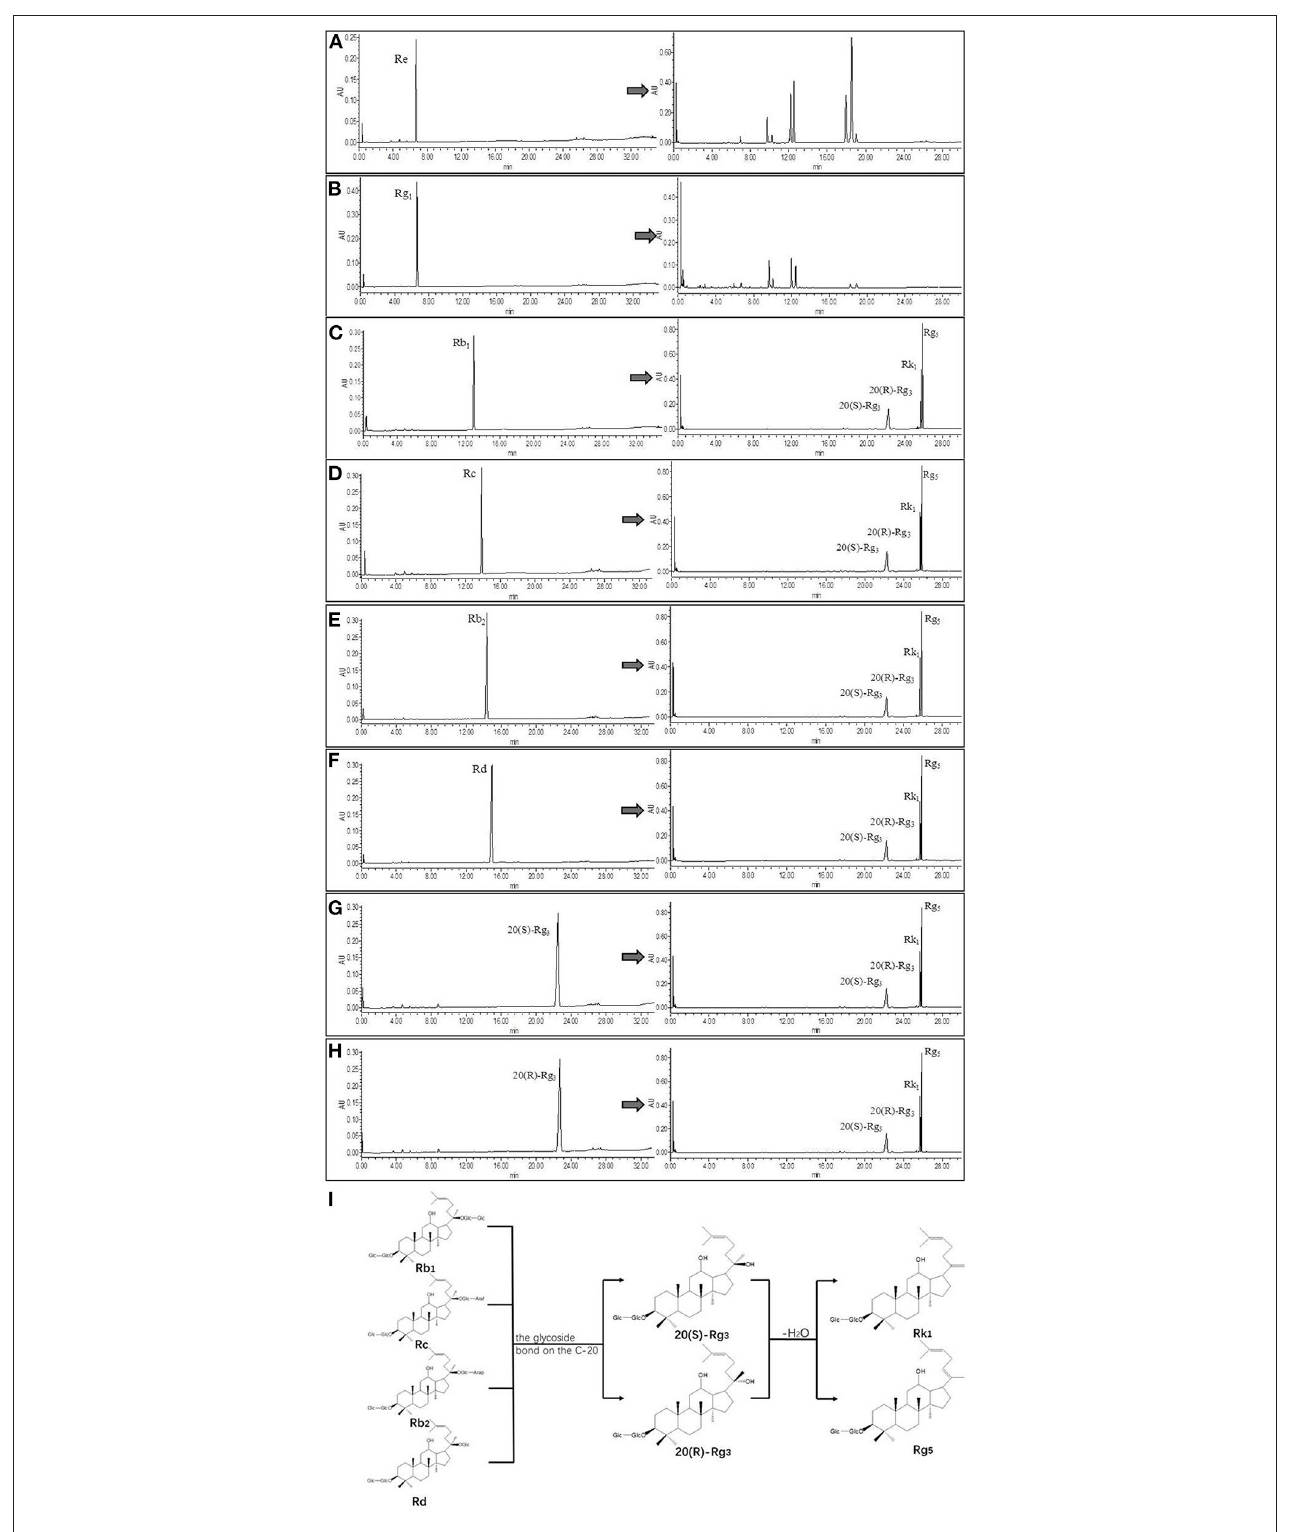
FIGURE 4 | UPLC comparison chart before and after monomeric saponin conversion ( n = 3). (A–H) is a comparison of UPLC before and after transformation of ginsenoside Re, ginsenoside Rg 1 , ginsenoside Rb 1 , ginsenoside Rc, ginsenoside Rb 2 , ginsenoside Rd, ginsenoside 20(S)-Rg 3 , and ginsenoside 20(R)-Rg 3 . (I) Transformation pathway of ginsenosides Rk 1 and Rg 5 in protopanaxadiol saponins.